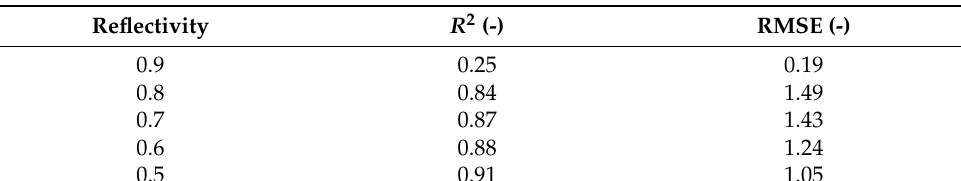
Table 7. Performance of the model of the potential maps of RC activity for different solar reflectiv- ity values.